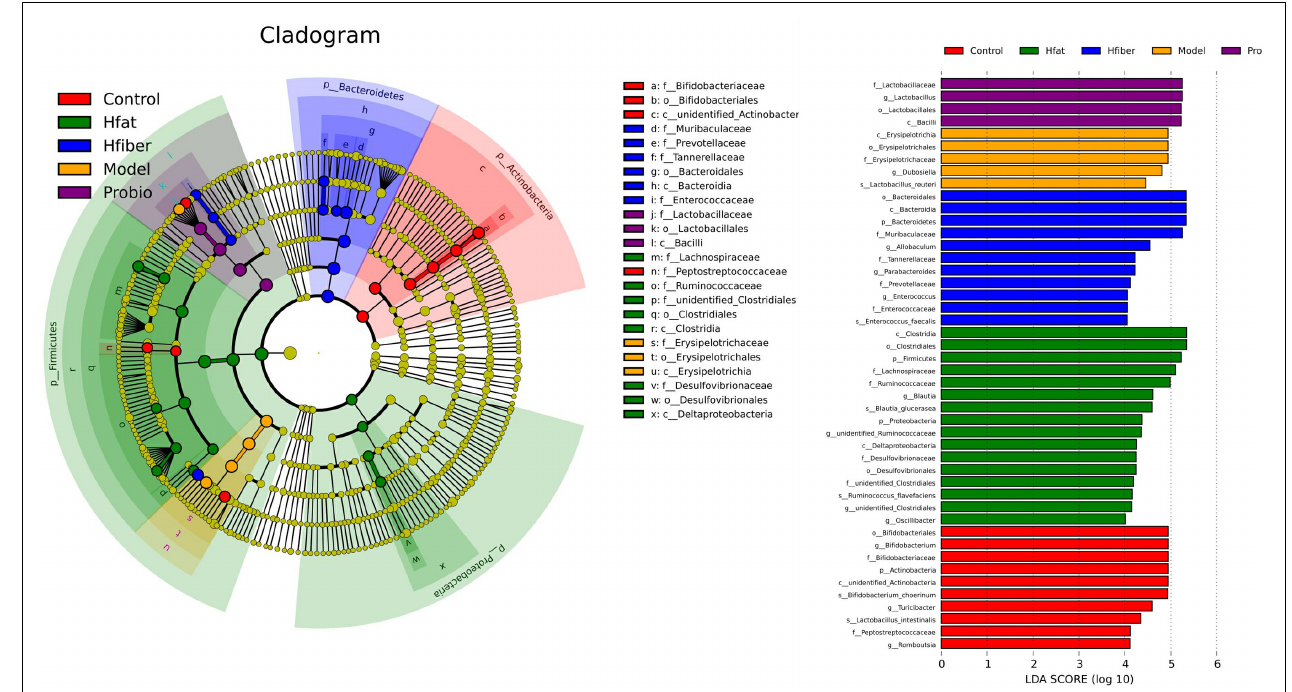
FIGURE 6 | Gut-microbiota comparison analyzed by LEfSe. In the cladogram, changes in the relative abundance of bacterial taxa identified by LEfSe are shown in phylogenetic trees from the phylum to the genus (from the inner to the outer ring, respectively). In the cladogram, the size of the node circle is proportional to the relative abundance of taxa. The node size corresponds to the average relative abundance of the OTU. Yellow indicates no significant difference between groups, and other colors (red, blue, purple, green, and orange) denote that OTUs have a significant difference between groups. Histogram of the LDA scores for differentially abundant genera. LDA scores were calculated by LEfSe using linear discriminant analysis to assess the effect size of each differentially abundant bacterial taxa. Only taxa meeting LDA > 4 are